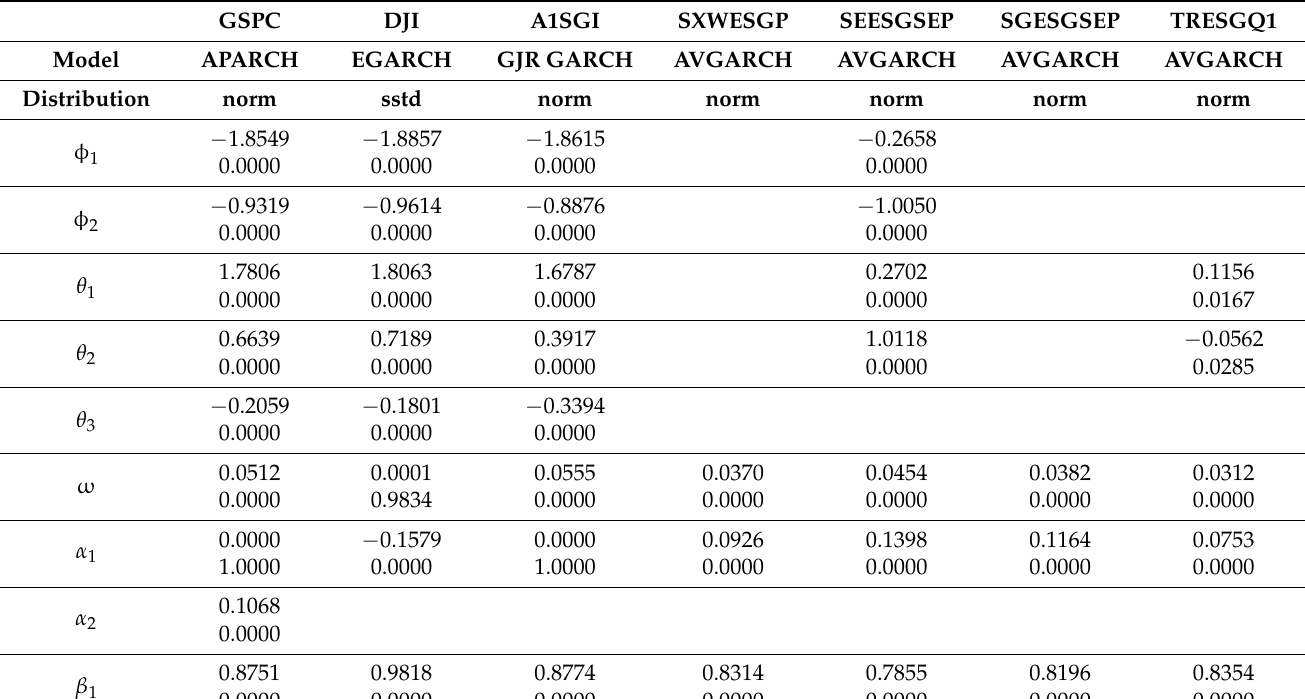
Table A2. Family ARMA-GARCH models, 3 July 2007–30 January